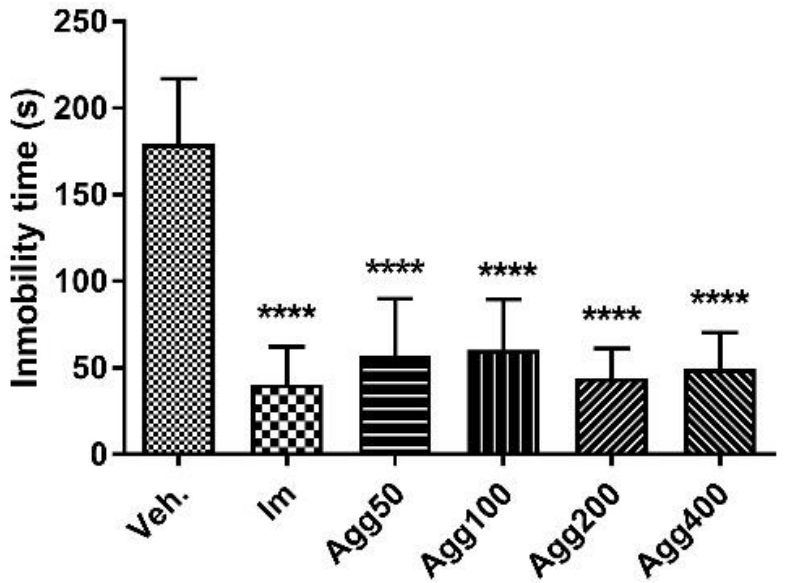
Figure 4. Immobility time (s) in the forced swimming test for the groups ( n = 6) treated orally for 7 days with Aloysia gratissima var. gratissima (Agg). Im.: imipramine. Veh: tween 80, 10%. The data correspond to the mean ± SD. One-way ANOVA and Dunnett’s post hoc test were performed. **** p < 0.0001.